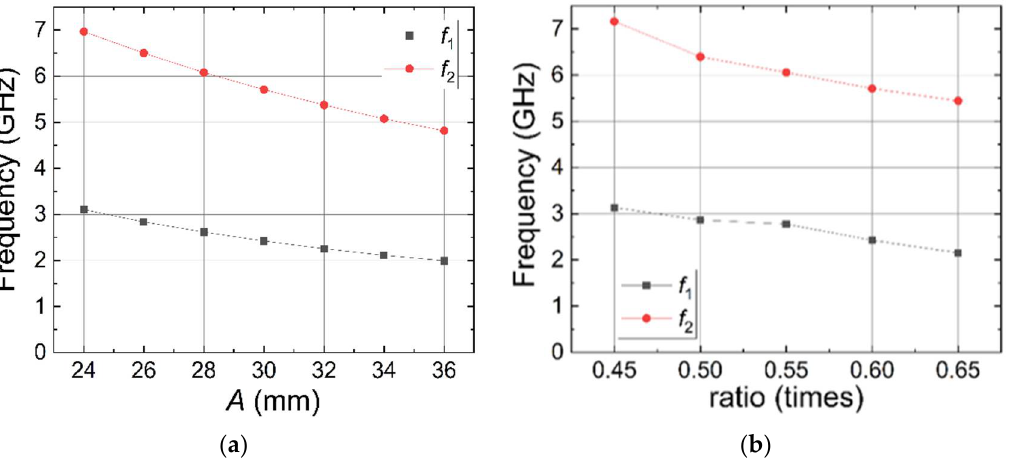
Figure 12. Dependence of antenna resonance frequencies on the size of the edge of the largest triangle ( a ) and dependence of antenna resonance frequencies on the ratio between edges of the fractal triangles ( b ).